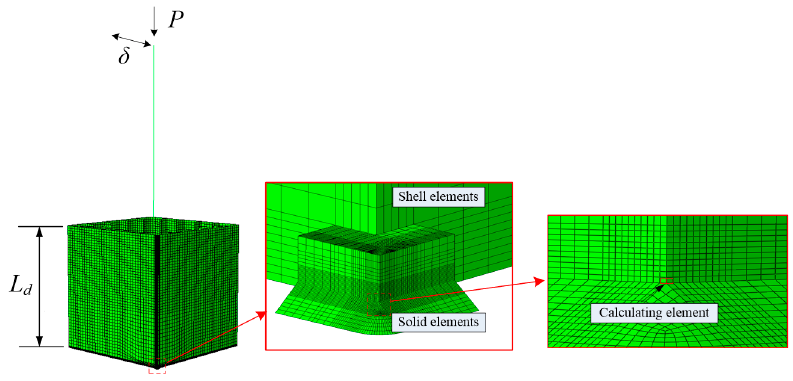
Figure 16. Analytical model of steel bridge piers.